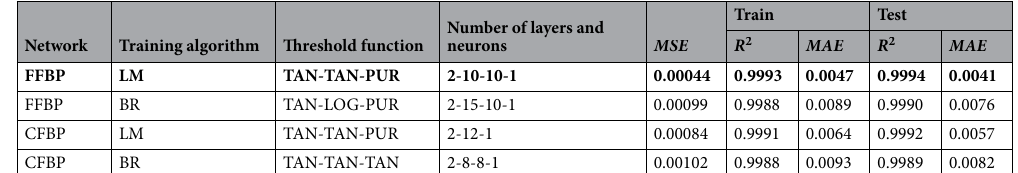
Network Training algorithm Threshold function